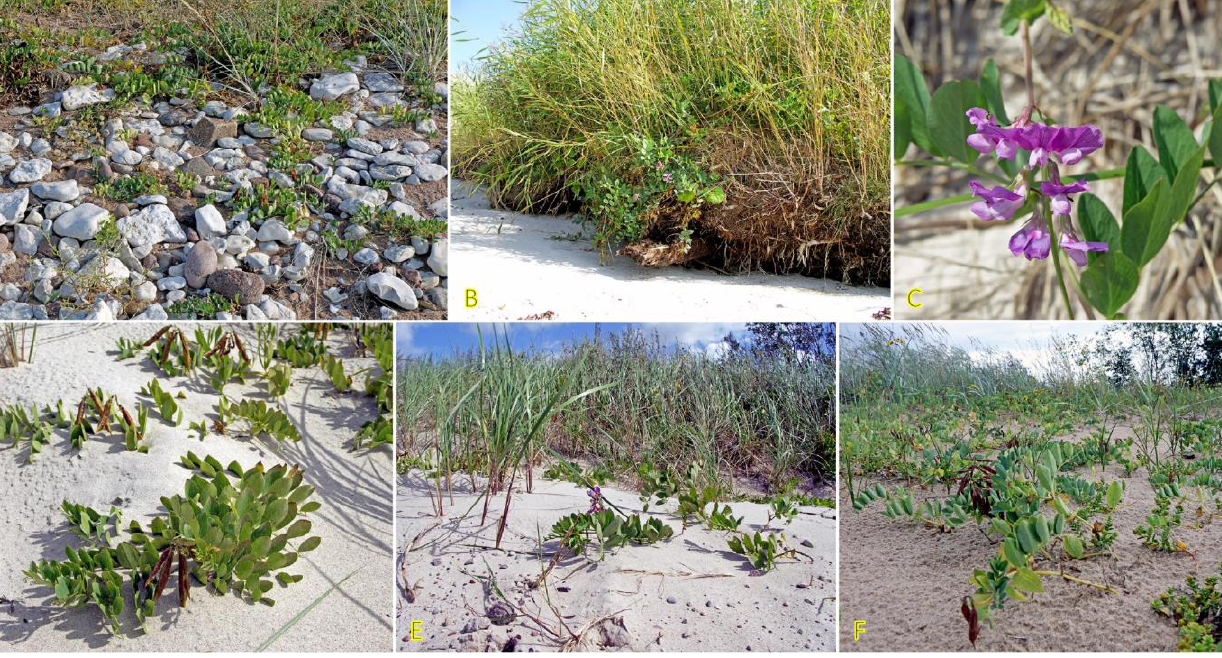
Figure 14. Lathyrus japonicus plants on a stony beach on the island of Hiiumaa, Estonia ( A ), on the edge of a marshy meadow together with Phragmites australis in Jūrmalciems, Latvia ( B ), detail of flowering individual in Jūrmalciem s, Latvia ( C ), on embryonic dunes in Pape, Latvia ( D ), on white dunes in Užava, Latvia ( E ), on white dunes in Carnikava, Latvia ( F ).